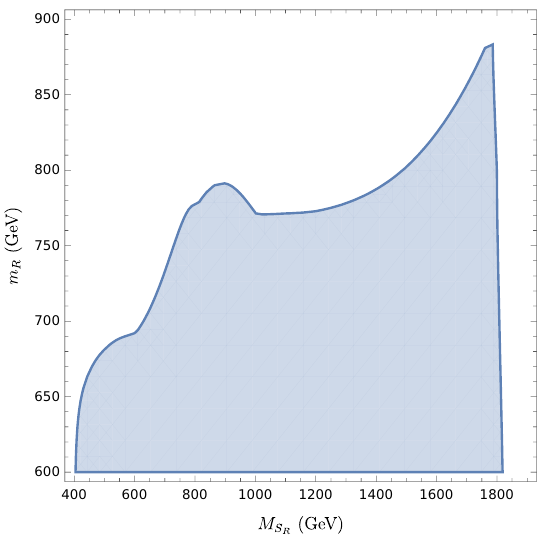
Figure 11 . A plot of parameter space excluded by the ATLAS search in [42]. Here the heavier (left) stop mass is fixed at 900 GeV, and all other parameters are as in benchmark B2.